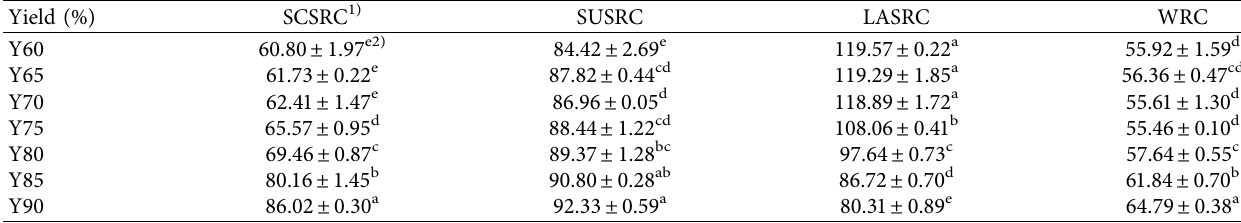
Table 4: Solvent retention capacity of wheat flour (var. Jokyoung) according to flour yield. Yield (%)